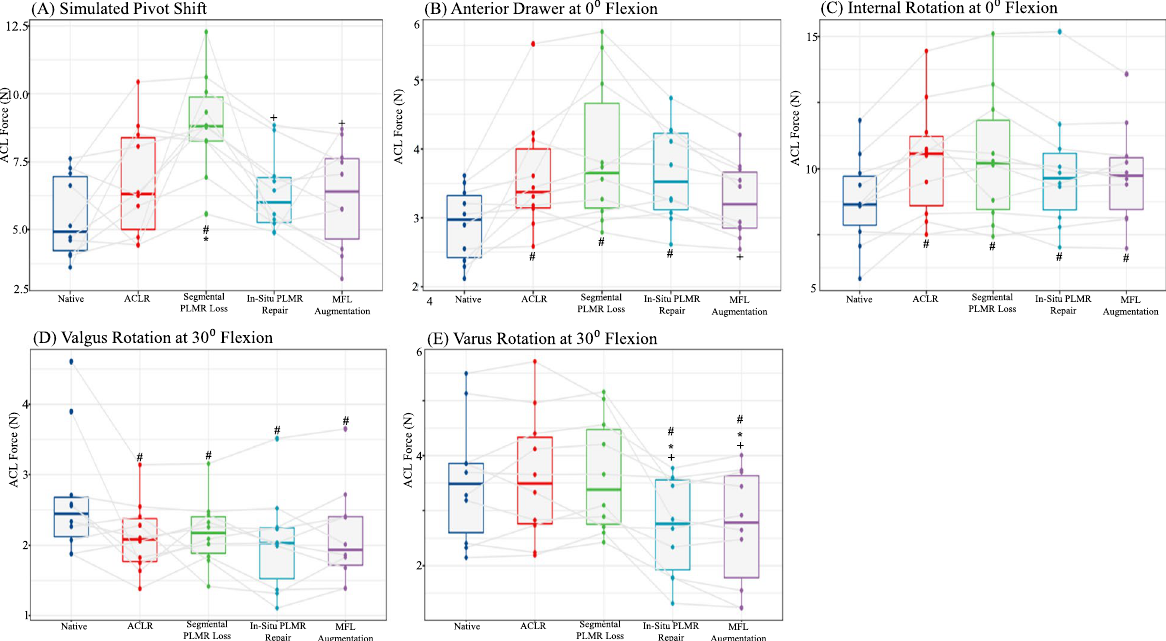
Fig. 4 Box plot graphs demonstrating median anterior tibial translation in mm for ( A ) the simulated pivot shift and ( B ) the anterior drawer at 0° flexion tests, and range of motion in ° for ( C ) the internal rotation at 0° flexion, ( D ) valgus rotation at 30° flexion and ( E ) varus rotation at 30° flexion tests. Dots represent individual specimen observations. Thick horizontal lines represent group medians, while top and bottom of boxes represent the 25 th and 75 th percentiles, respectively. #: significant from native; *: significant from ACLR; : significant from segmental +